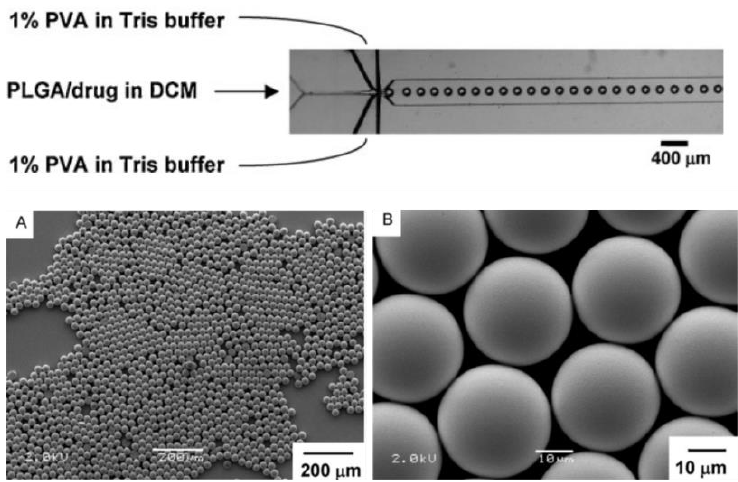
Figure 5. Poly( L -lactide- co -glycolide) PLGA microparticles prepared via a flow-focusing device. Above, an optical micrograph of the orifice of the flow-focusing region generating droplets of the dispersed phase in the continuous phase is displayed. Below, scanning electron micrographs of the resulting particles at low ( A ) and high ( B ) magnification are represented. Reprinted from [66] with permission from Wiley Online Library, 2009.